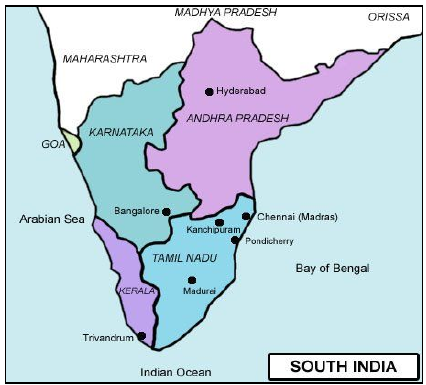
Figure1. Graphical representation of South